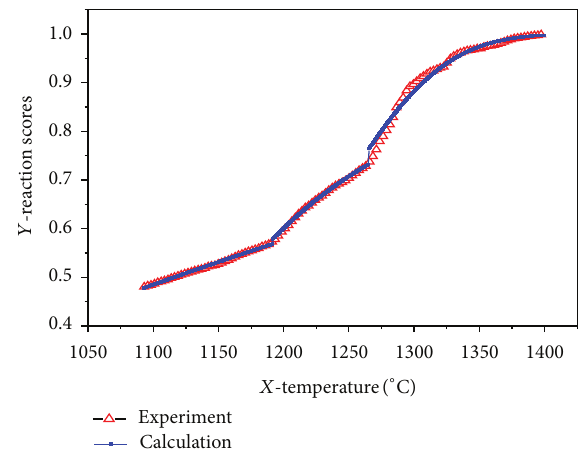
Figure9:Therelationofoppositeangleslengthofgraphandheating rate.